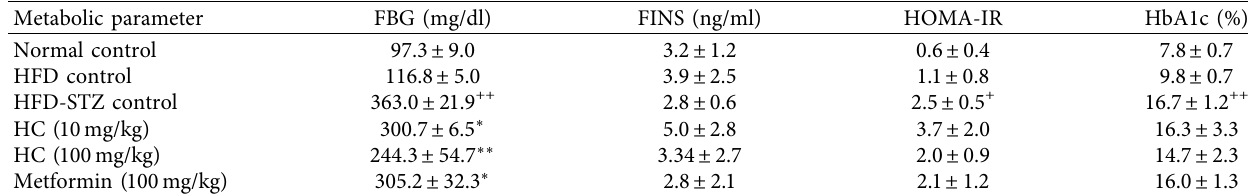
Table 3: Levels of FBG, FINS, HOMA-IR, and HbA1c.